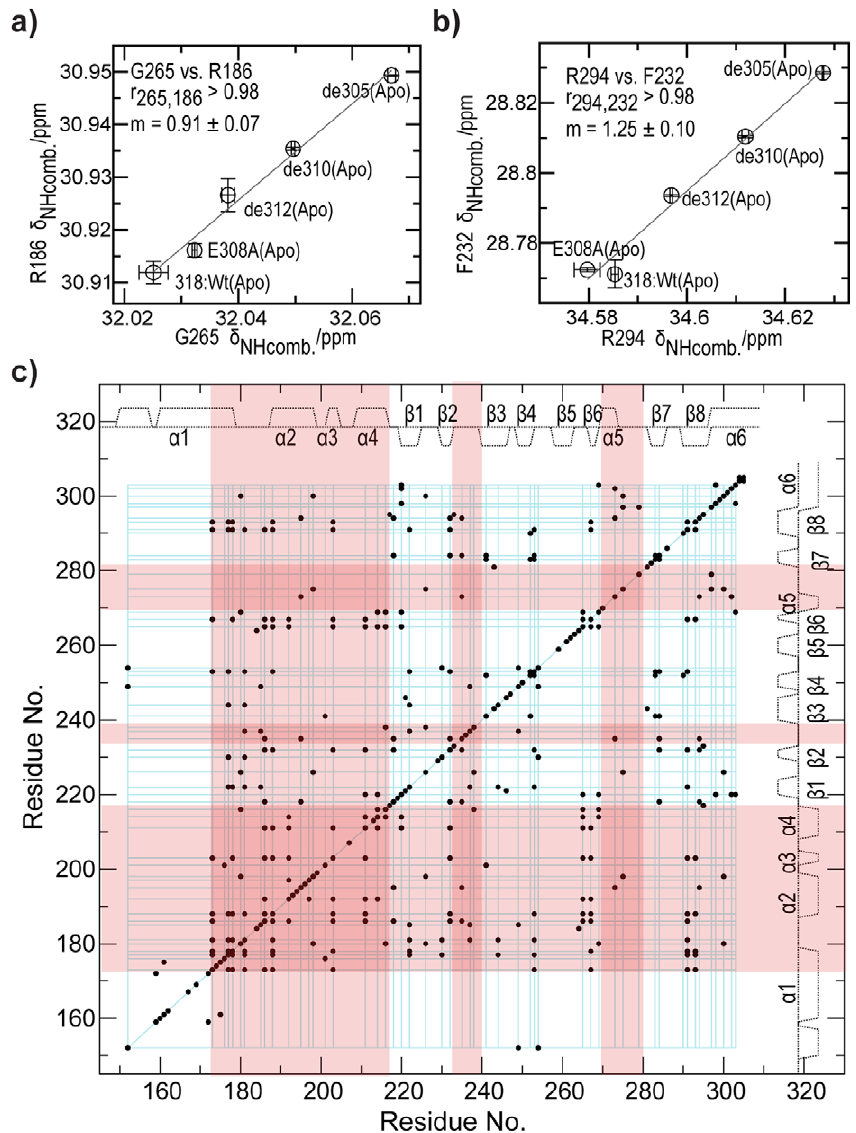
Figure 5. Chemical shift covariance analysis (CHESCA) of the hinge helix mutants. a ) and b ) show representative inter-residue chemical shift correlation among the five apo states (318:Wt, 318:E308A, de312, de310, and de305) and ‘m’ defines the slope. c) The chemical shift correlation matrix. Residue pairs with absolute correlation coefficients $ 0.98 are marked with a dot. The blue grid represents the largest agglomerative cluster (Figure S2 in Supporting Information) [26], while regions highlighted in red correspond to key allosteric sites of the CBD other than the hinge